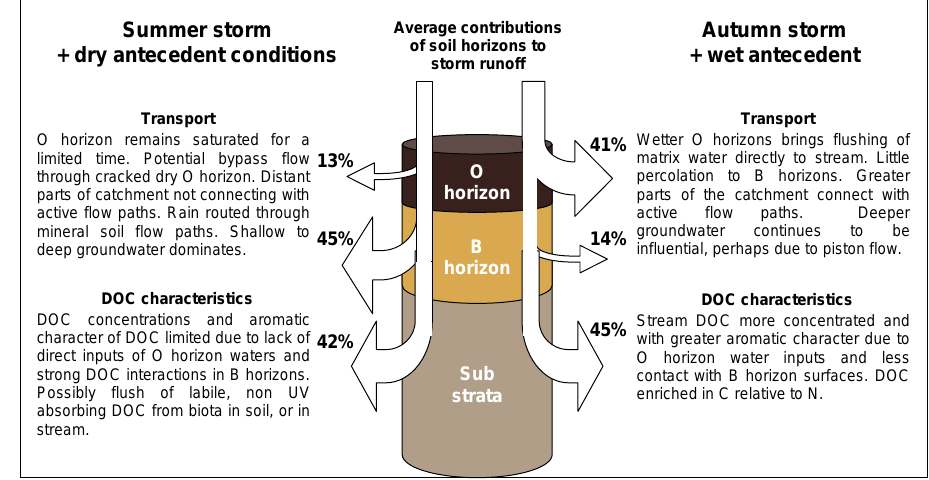
Figure 9. Conceptual model of the contrasting conditions of summer (on the left) and autumn (on the right) in terms of DOC transport dynamics to the stream. The average flow contributions from horizons are those determined by the EMMA. While a podzol profile is shown the contributions of the O horizon waters may also come from a peat soil.